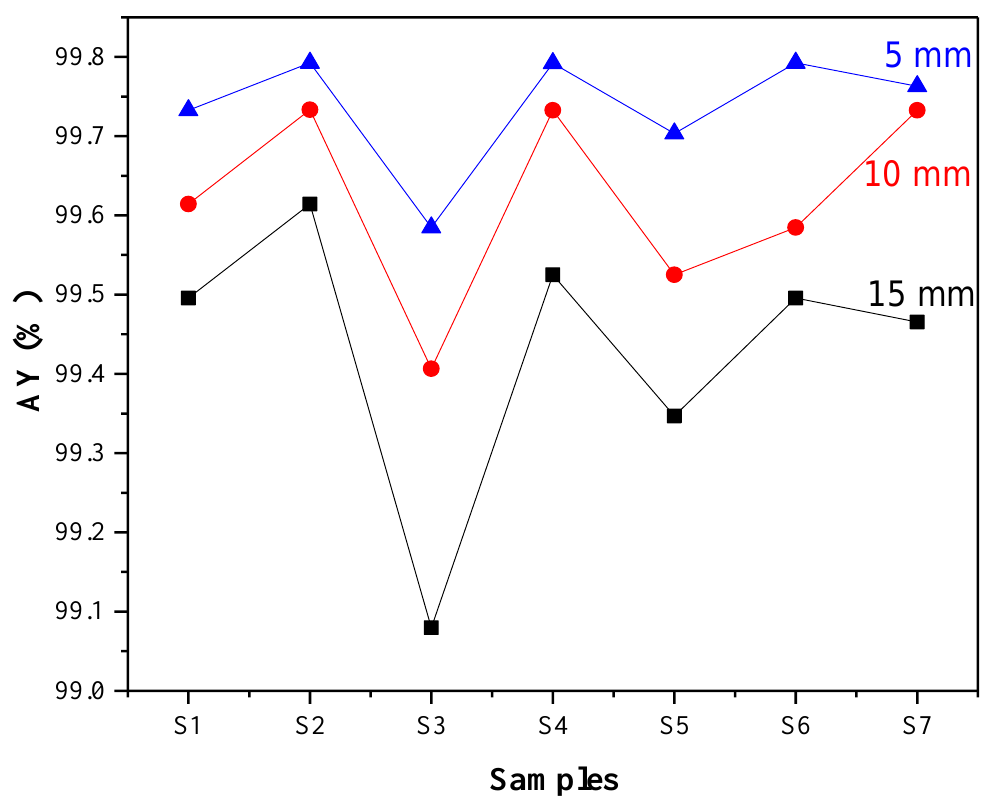
Figure 6. Radiative attenuation rate of the synthetized clay samples with different thicknesses (x = 5, 10, and 15 mm).